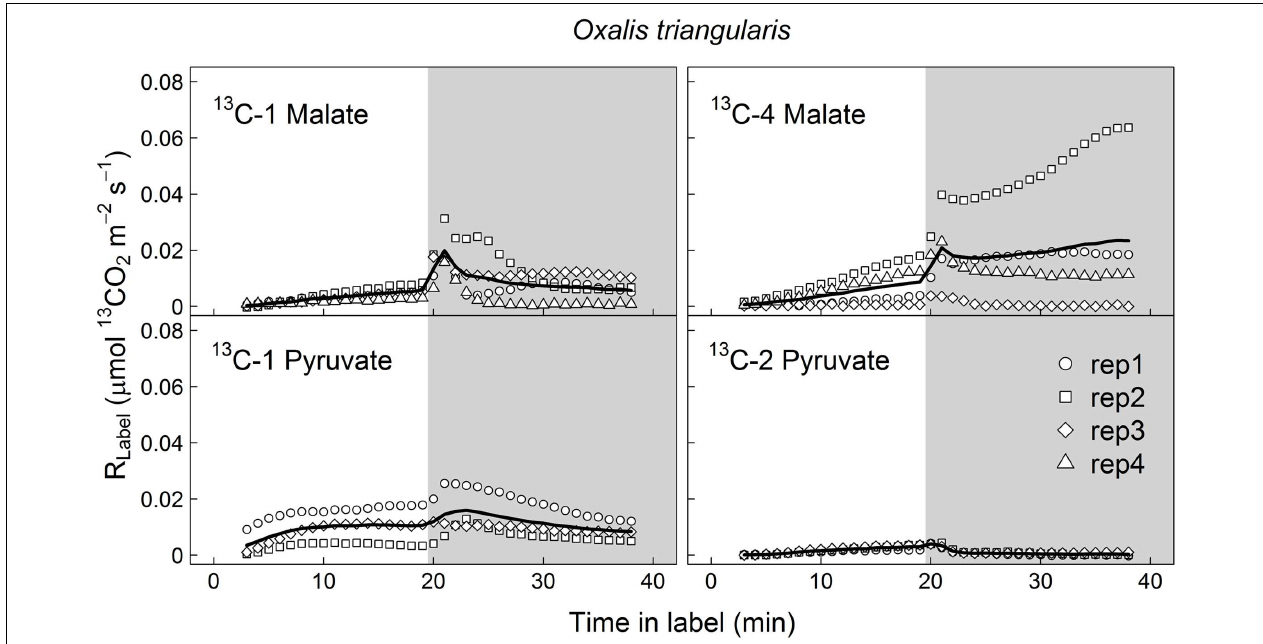
FIGURE 2 | Label-derived leaf 13 CO 2 respiration ( R Label , µ mol 13 CO 2 m − 2 s − 1 ) during light–dark transitions in Oxalis triangularis . Leaves were fed with position-specific 13 C-labeled malate ( 13 C-1, 13 C-4) or pyruvate ( 13 C-1, 13 C-2) for about 40 min (20 min in the light and 20 min in the dark). Gray areas denote dark periods. Black bold lines denote mean values, while symbols indicate single replicates ( n = 3–4 individuals).